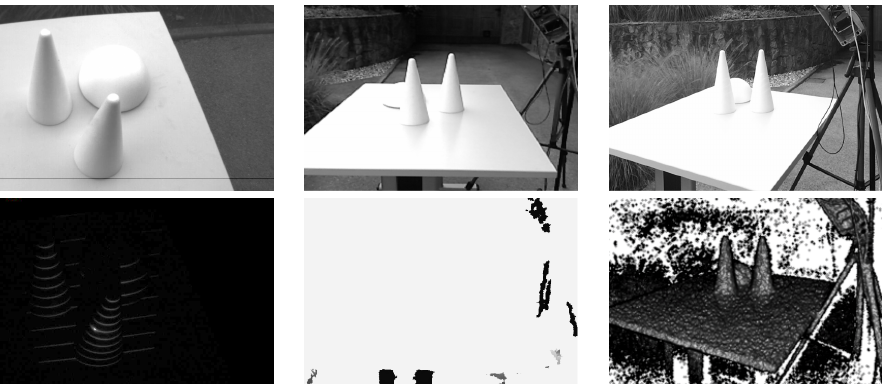
Figure 12. Qualitative comparison of the ATRIS sensor and both generations of the Kinect sensor on an outdoor scene. The first column shows the scene and distortion map from the perspective of the ATRIS sensor; the second column presents images from the first generation Kinect; and the last column of images shows the results produced by the second generation Kinect. Note that the second generation Kinect that uses time of flight technology, and our ATRIS sensor produces good results in all pixels measured, whereas the first generation Kinect performs less well